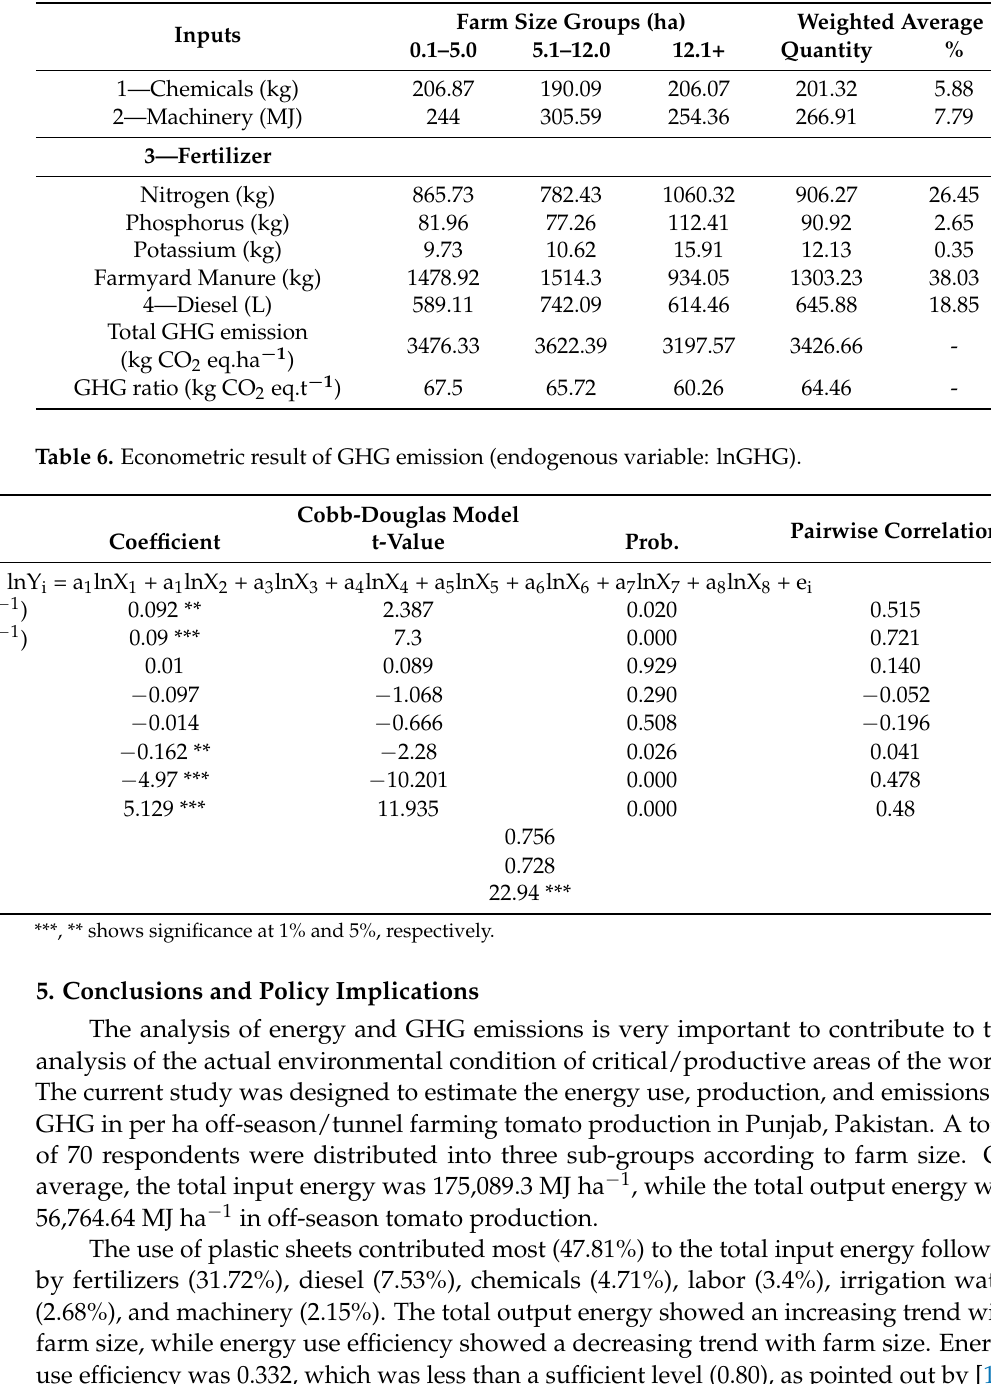
Table 5. GHG (kg CO 2 eq. ha − 1 ) in off-season tomato production.